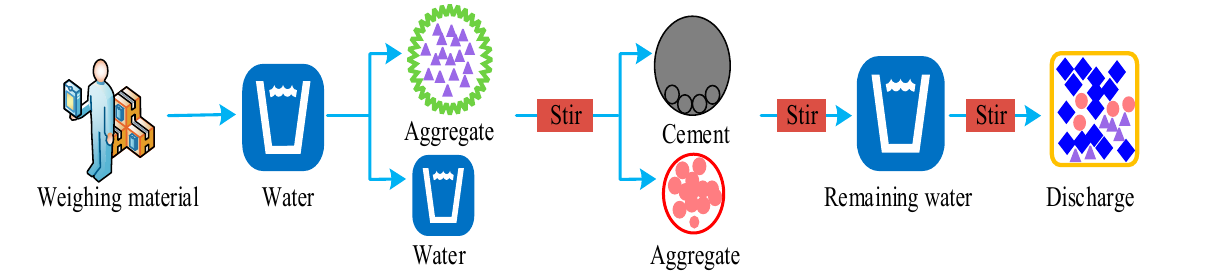
Figure 1. Forming process of rubber aggregate periodic concrete.